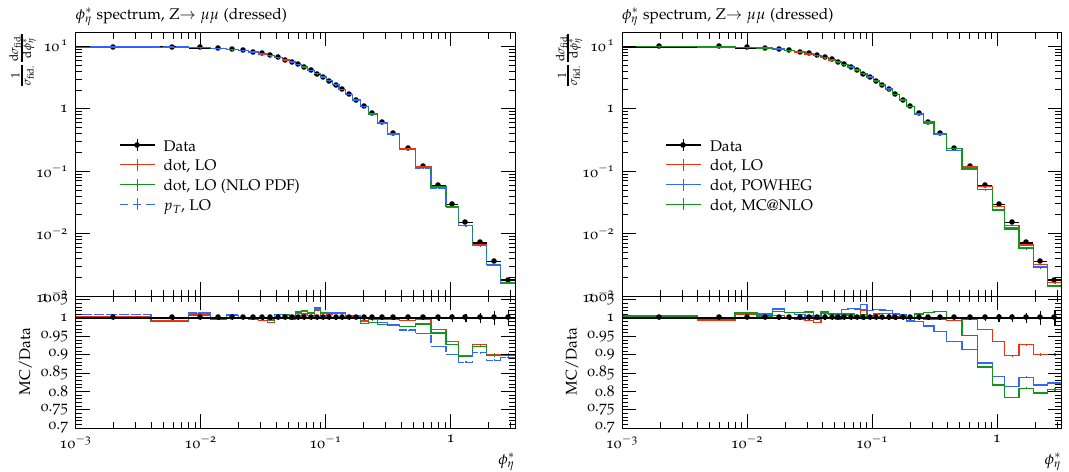
Figure 3 . Normalised differential cross section of Z → µ + µ − as a function of the φ ∗ the Z boson. Herwig results compared to ATLAS [15] data at 7 TeV. In the left pane, a comparison of LO results from the dot-product (with both LO and NLO PDFs) and p ⊥ preserving schemes. In the right pane, a comparison of LO and NLO results in the dot-product preserving scheme.